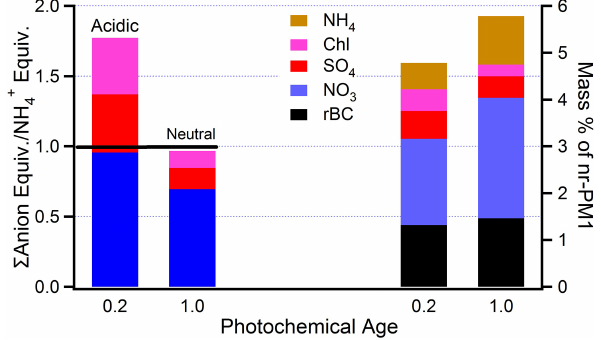
Figure 11. Ratios of excess plume variables as a function of pho- tochemical age. (a) rBC/nr-PM1; (b) absorption/rBC (m 2 g − 1 ) ; (c) absorption/nr-PM1 (m 2 g − 1 ) ; (d) single scatter albedo at 550nm. Panels b, c, and d do not include flight 725a because of missing PTI-absorption measurements. Format same as Fig. 10.